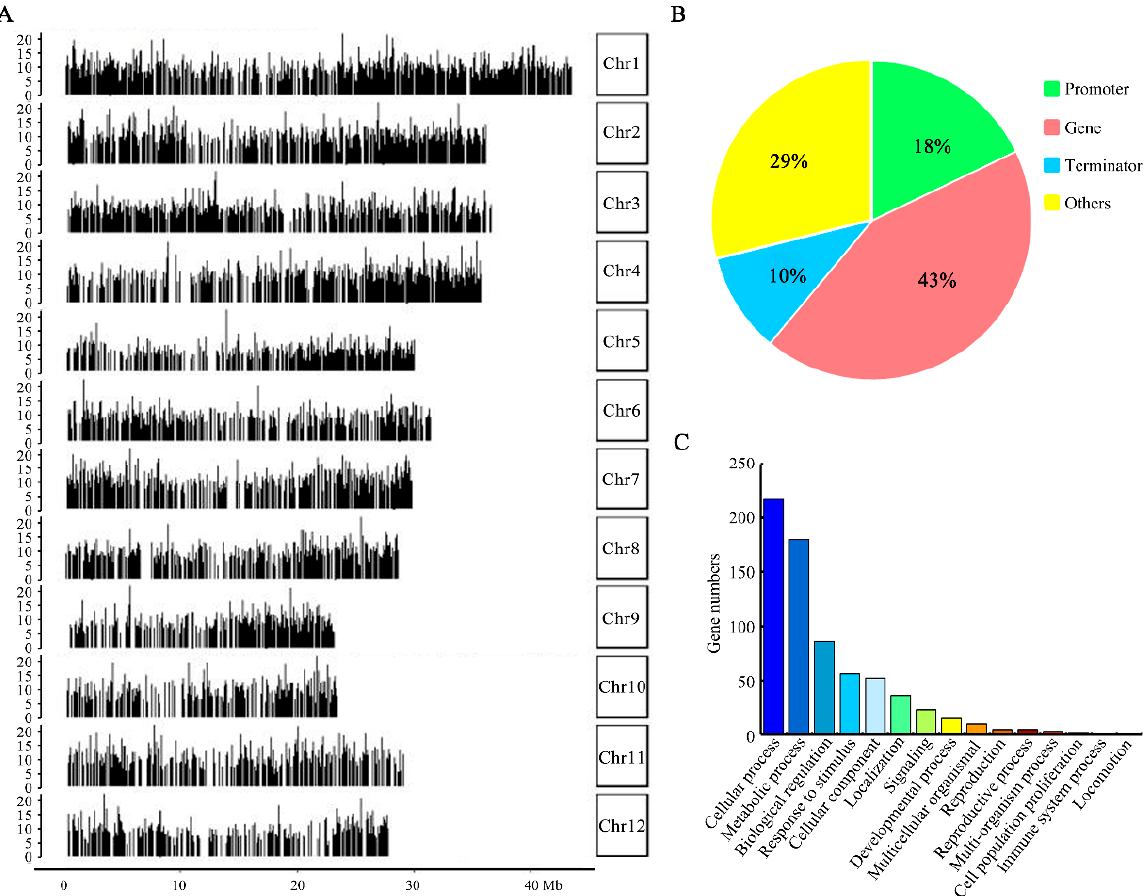
sites along the twelve chromosomes of rice. ( B ) Distribution of OsbZIP09-binding sites in genic and intergenic regions. ( C ) Biological process categorization of OsbZIP09-regulated target genes using gene ontology (GO)